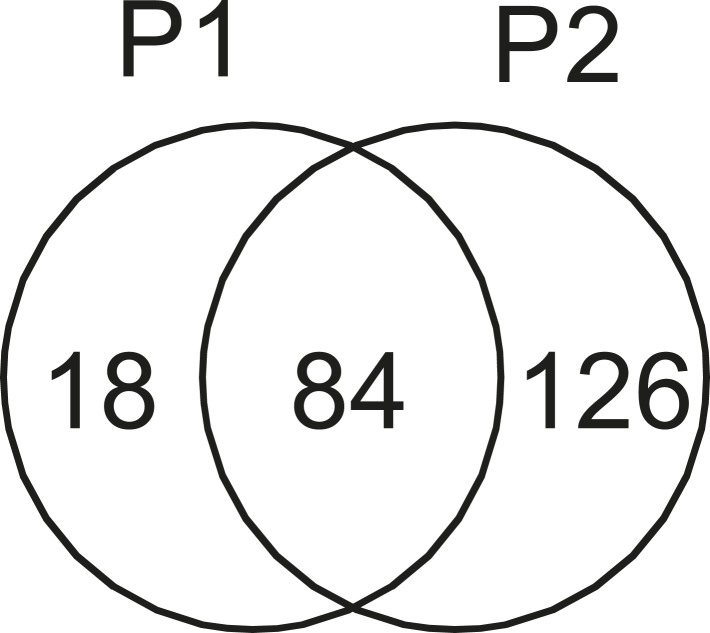
Correlation of biological replicates.Biological replicates of STOMP analysis of amyloid plaque material from TgCRND8 mice show good repeatability. Using our thresholding criteria (at least three spectral counts for each identified protein, at least threefold excess over corresponding dark control) one sample run (P1) identified fewer total proteins than the other (P2), however most proteins identified in P1 were also detected in P2.